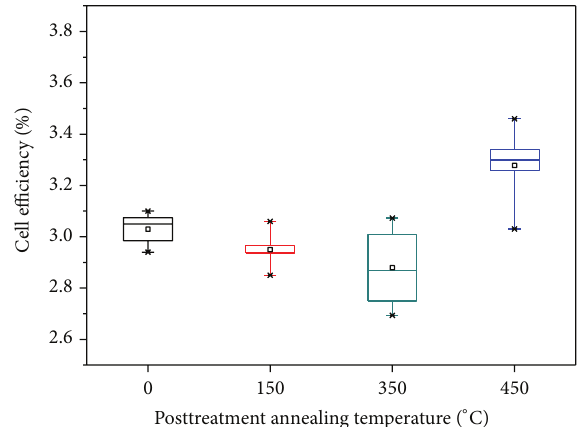
Figure 5: Box plots of the dependence of the efficiency of the DSSCs on the photoanode posttreatment